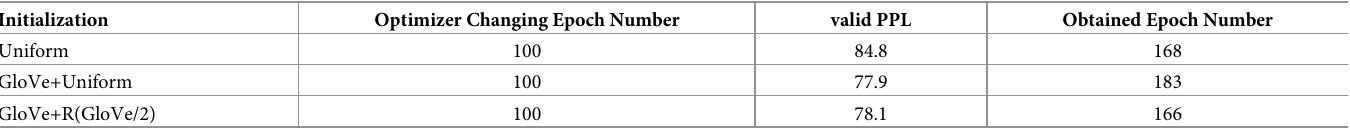
Table 8. The results of the back-tracking procedure with hybrid